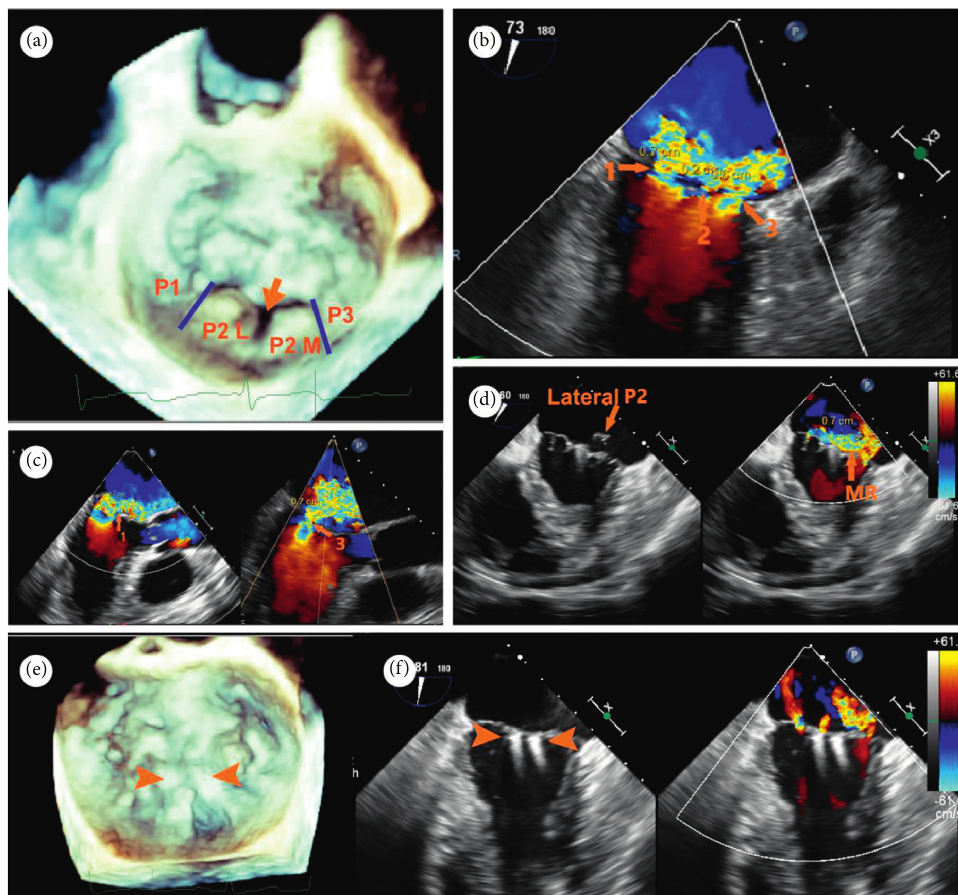
Figure 7: A 79-year-old male patient was referred for a history of chronic dyspnea (New York Heart Association functional class IV. (a) 3D enface view of the MV demonstrating a central cleft-like indentation with a prolapse lateral P2 (P2 (L) and a prolapse medial P2 (P2 (M). (b, c) 2D CDF TEE showing two dominant regurgitant jets (VCW: 7mm and 6 mm, resp.) originating from the two prolapse P2 segments and a mild jet (VCW: 2mm) from the central P2 indentation on bicommissural view and LVOT view. (d) Heart team decision was made on transapical ValveClamp implantation after his being deemed too high risk for surgical intervention. Implantation of the first clamp led to correction of the medial P2 segment, while the lateral P2 segment remained prolapse with a significant residual MR jet. (e) After im- plantation of the second clamp at the P2 segment, prolapse segments and regurgitant orifice were corrected and leaflet coaptation was preserved. (f) 2D CFD TEE showing mild residual jets (this case was diagnosed and treated before the TrueVue technique was commercially